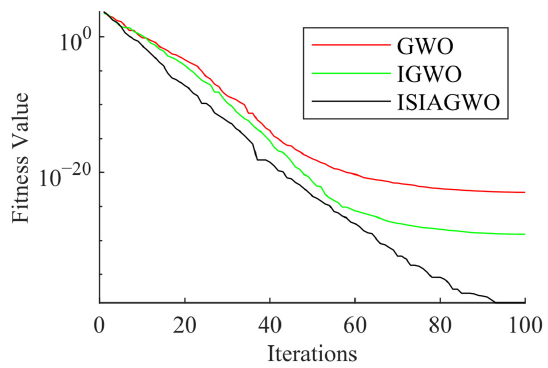
Figure 3. Sphere function optimization curve.